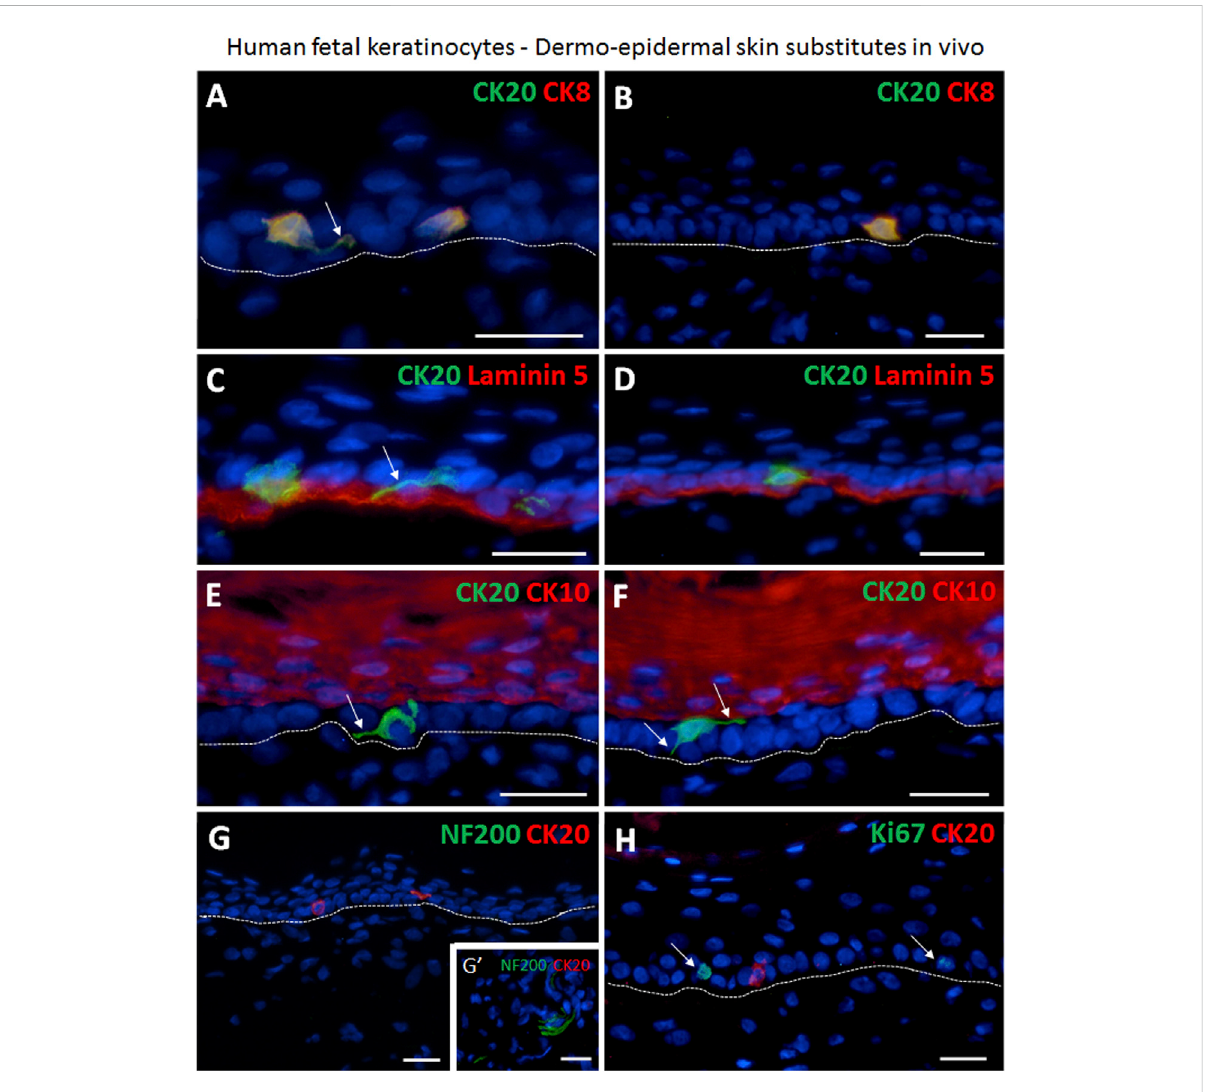
FIGURE 5 Immuno fl uorescence staining demonstrating the presence of human Merkel cells in human dermo-epidermal skin substitutes 4 weeks after transplantation in an animal model. (A,B) Examples of CK20 (green) and CK8 (red) double positive Merkel cells in the epidermis. Merkel cells are situated as single cells. Note that CK8 is expressed only in Merkel cells. White arrow depicts dendritic protrusion of a non-oval Merkel cell. (C,D) Basement membrane component Laminin 5 (red) and CK20 (green) expression. White arrow denotes dendritic protrusion of non-oval Merkel cell. (E,F) Suprabasal keratinocyte marker CK10 (red) and CK20 (green). CK20-positive Merkel cells reside in the basal layer of the epidermis. White arrows indicate dendritic protrusion of non-oval Merkel cells. (G,G 9 ) Four weeks after transplantation, the CK20-positive (red) Merkel cells were still not associated with host nerves. (G 9 ) shows a neuro fi lament 200 (NF200, green) positive host nerve still not projecting into the human dermis of the substituteservingaspositivecontrolforthestaining. (H) Expression ofKi67(green)andCK20(red).Theproliferation markerKi67isnotpresentinthe CK20-positive Merkel cell. White arrows mark Ki67-positive cells. Dashed white lines indicate locations of dermal-epidermal junctions. Hoechst 33342 (blue) was used to counterstain nuclei. Scale bars: 25 μ